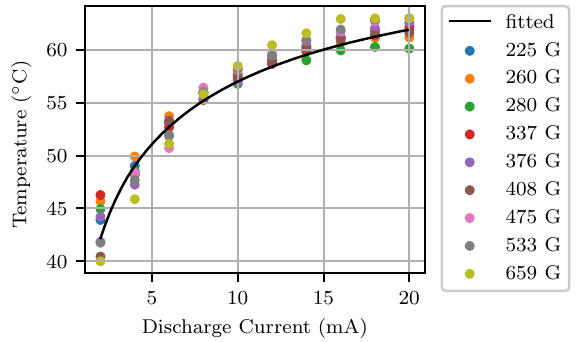
Figure 6. The fitted equivalent temperatures of the HCL at different magnetic fields versus the discharge current (color dots) and the fitted curve (black line) of the equivalent temperature of the HCL versus the discharge